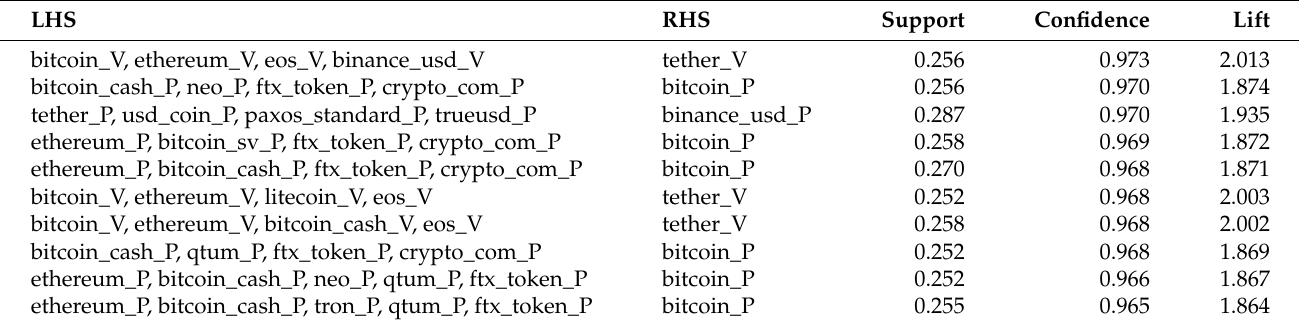
Table 2. Top 10 association rules for Subset 1 of price and volume returns ordered by confidence. LHS RHS Support Confidence